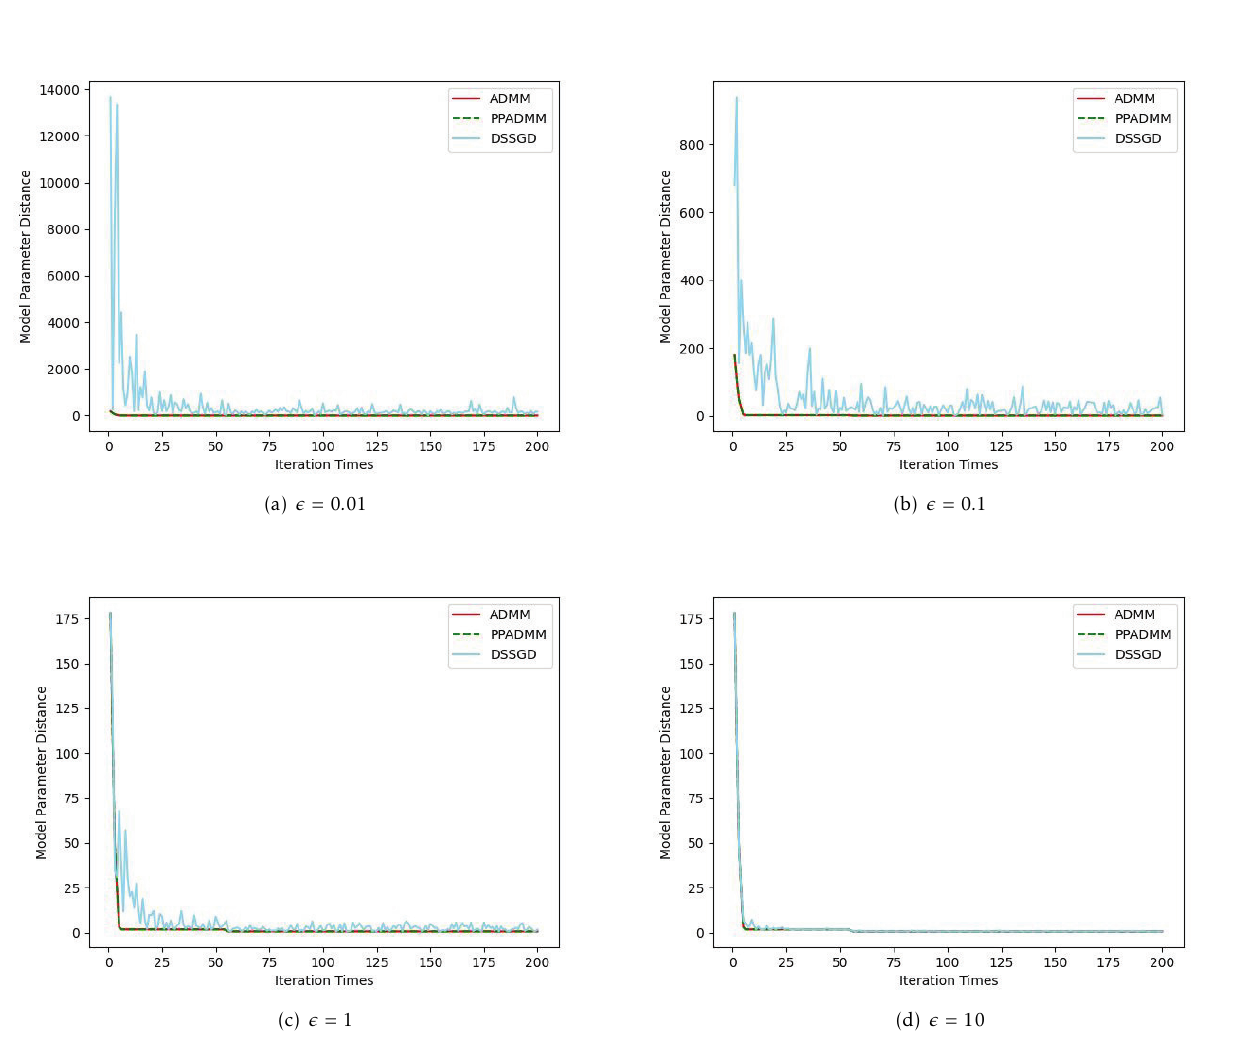
Figure 4. Relationship between MPED and iteration number under ADMM, PPADMM, and